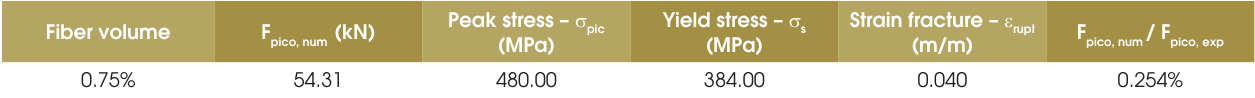
Table 16 – Model parameters for homogenization of La Borderier [4] for the beam V8 with 0.75% steel fibers by Oliveira [17]